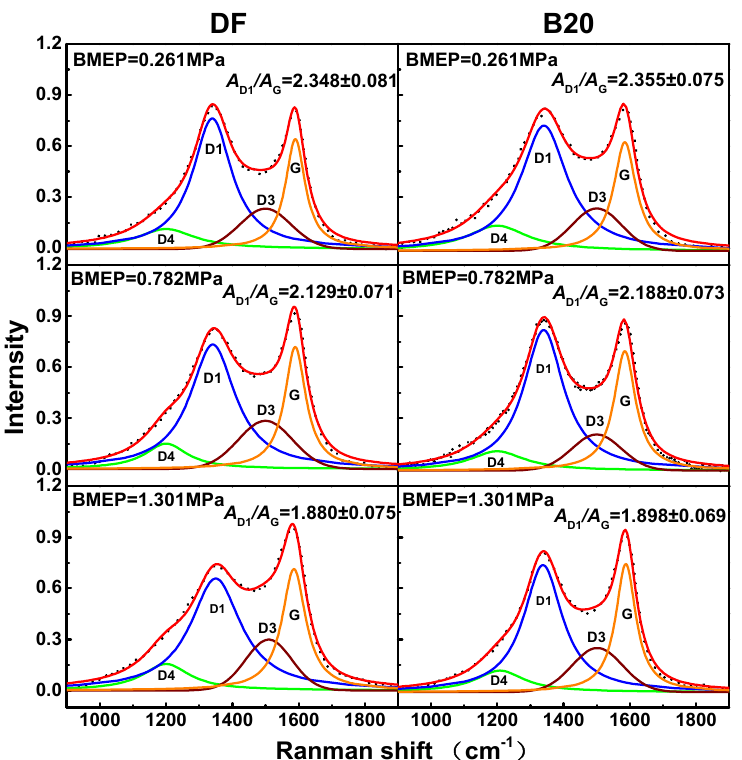
Figure 8. Raman spectroscopy analysis for the DF and B20 soot under test working conditions.